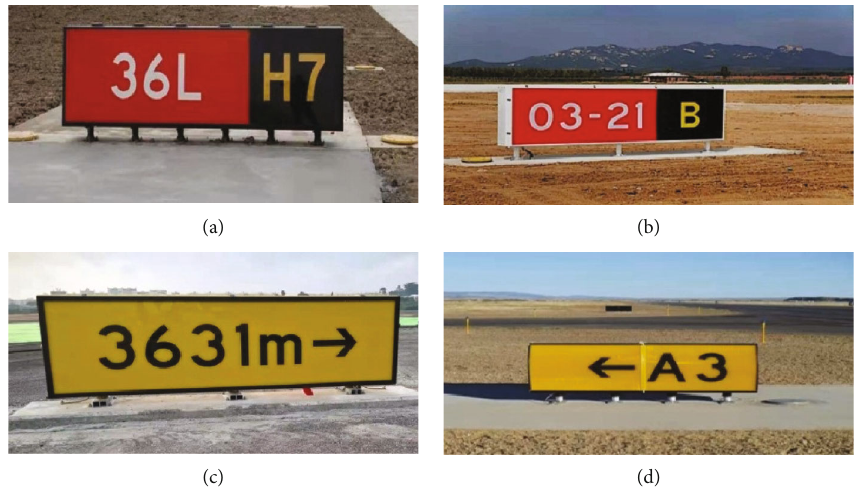
Figure 1: Original images taken at an